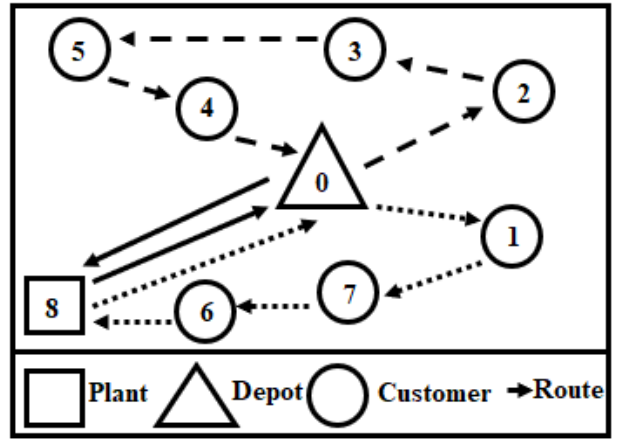
Figure 1. Collection and distribution network in an EDPRP.